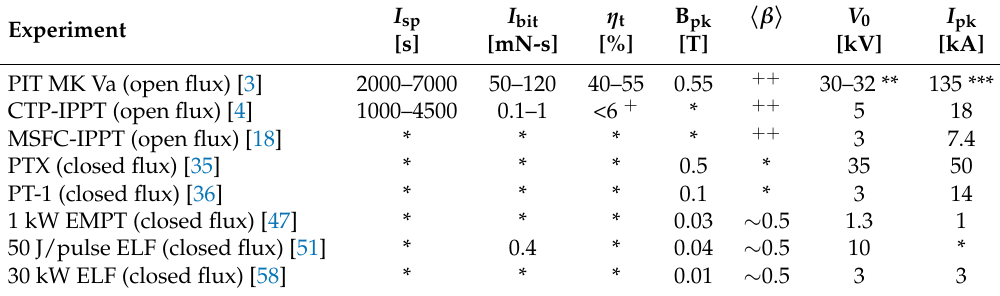
Table 1. Summary of operating parameters and test data for various IPPTs. (* data not